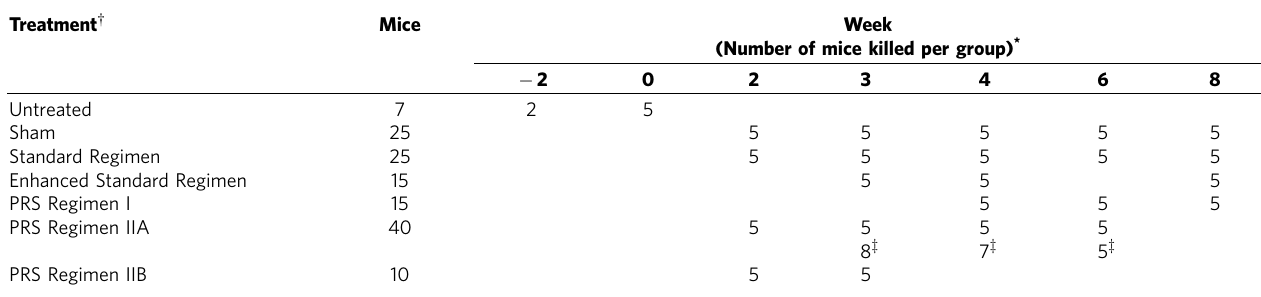
Table 2 | Scheme of medium-term efficacy and relapse study. Treatment w Mice Week